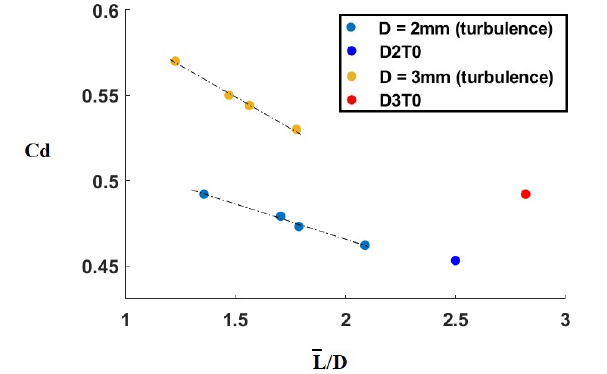
Figure 15. Drag coefficients of the simulated water droplets with respect to the lengths of their wake recirculation areas (exact values and the corresponding cases are shown in Table 5).